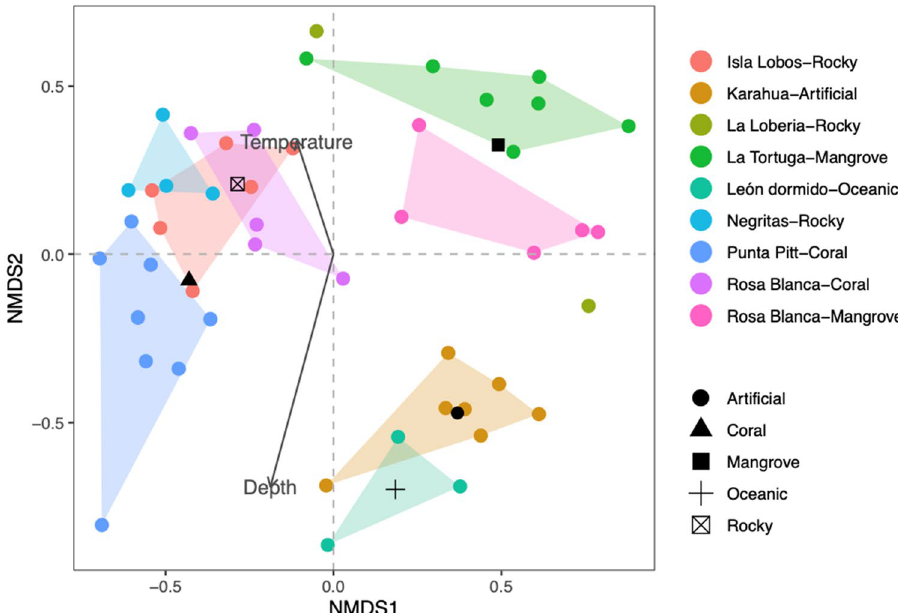
Figure 4. Non-metric multidimensional ordination based on the abundance per sample (dots) of the fish community in the southeastern Galapagos Islands. Convex hulls encloses all samples per site. Additionally, the vectors and centroids of the environmental variables correlate with the fish community structure.